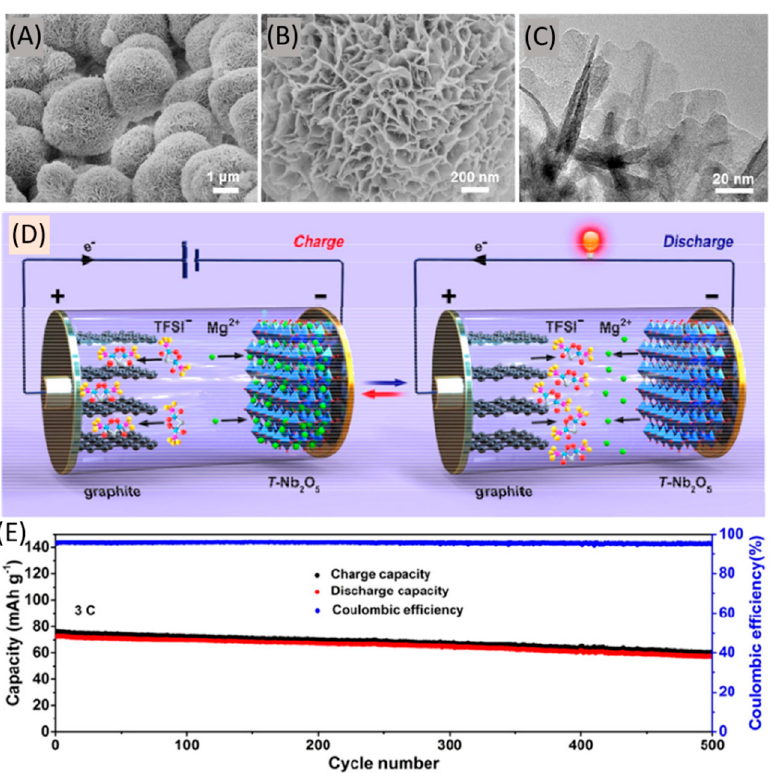
Figure 13. ( A ) Low- and ( B ) high-magnification SEM images and ( C ) TEM image of the Ti–Nb 2 O 5 NFs; ( D ) Operating principle of the magnesium-ion dual-ion battery and ( E ) its long-term cycling performance at 3C with Ti–Nb 2 O 5 NFs as anode. Adapted with permission from [177]. Copyright American Chemical Society, 2020.